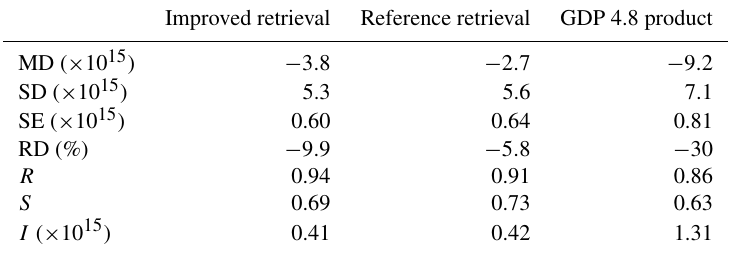
Table B1. Mean difference (MD, SAT-GB in 10 15 molec.cm − 2 ), standard deviation (SD, in 10 15 molec.cm − 2 ), standard error of the mean (SE, in 10 15 molec.cm − 2 ), relative difference (RD, (SAT-GB)/GB in percent), and correlation coefficient R , slope S , and intercept I (in 10 15 molec.cm − 2 ) of the orthogonal regression for the monthly mean GOME-2 tropospheric NO 2 product when compared to MAXDOAS data at the suburban Xianghe station. Values for the improved retrieval (this study) are given, and values for the reference retrieval and the current operational GDP 4.8 product are reported. Results are reported for a cloud radiance fraction less than 0.5 for a total of 77 GOME-2 monthly points.